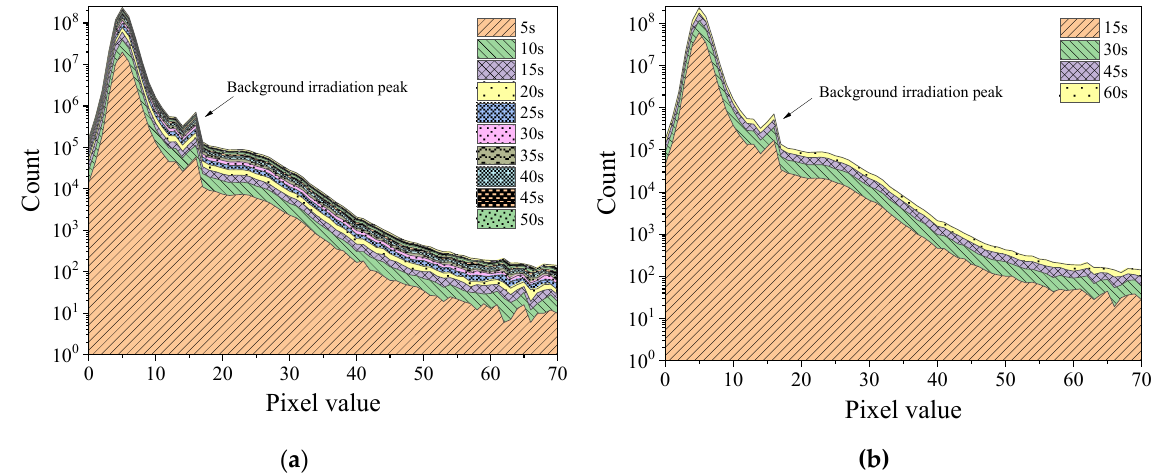
Figure 6. Histogram of the mixed radiation field of Am-Be source and 60 Co source at 6.13 mGy/h (24 frames per second). ( a ) Stack once every 5 s. ( b ) Stack once every 15 s.